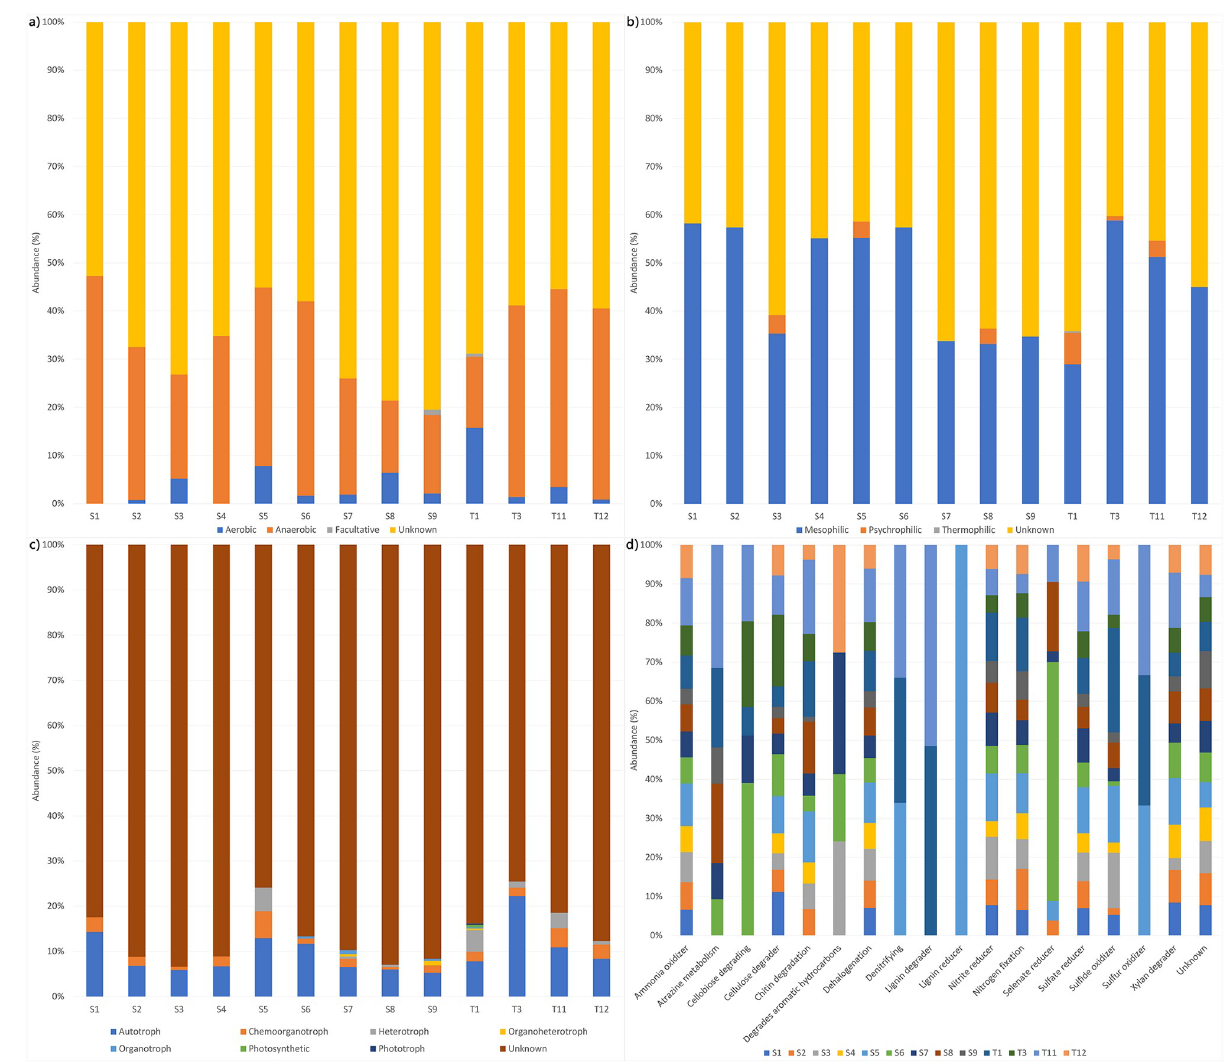
Fig 3. Putative metabolic requirements and activities of microbial communities of samples S and T. (A) Oxygen requirements, (B) temperature ranges, (C) energy sources, (D) type of metabolism. https://doi.org/10.1371/journal.pone.0220329.g003 Table 4. Percentage of the top four dominant phyla in the microbiome of stranded sea turtles and main features of the corresponding studies. Sea Firmicutes Bacteroidetes Proteobacteria Fusobacteria turtle